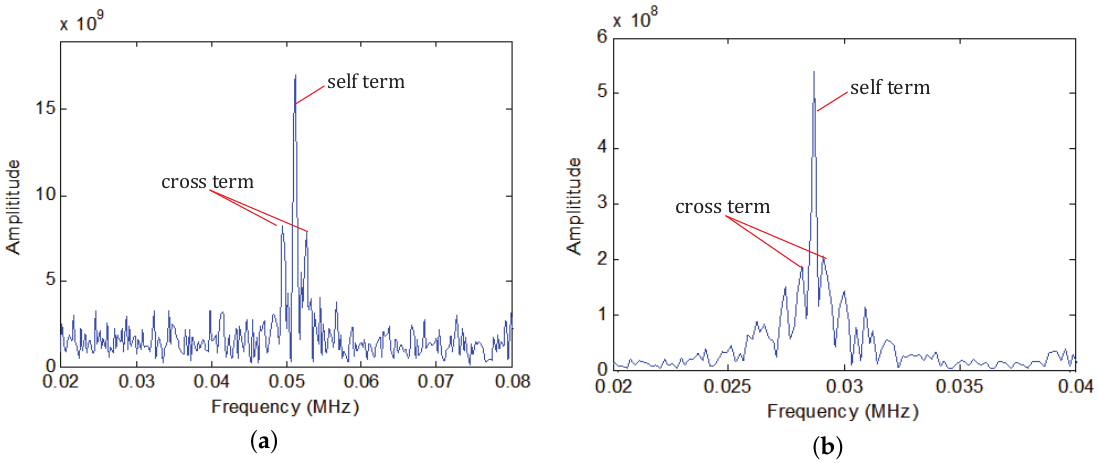
Figure 9. The spectrums of the cross-correlation results. ( a ) The spectrum of the cross-correlation result of radar Dataset 1. ( b ) The spectrum of the cross-correlation result of radar Dataset